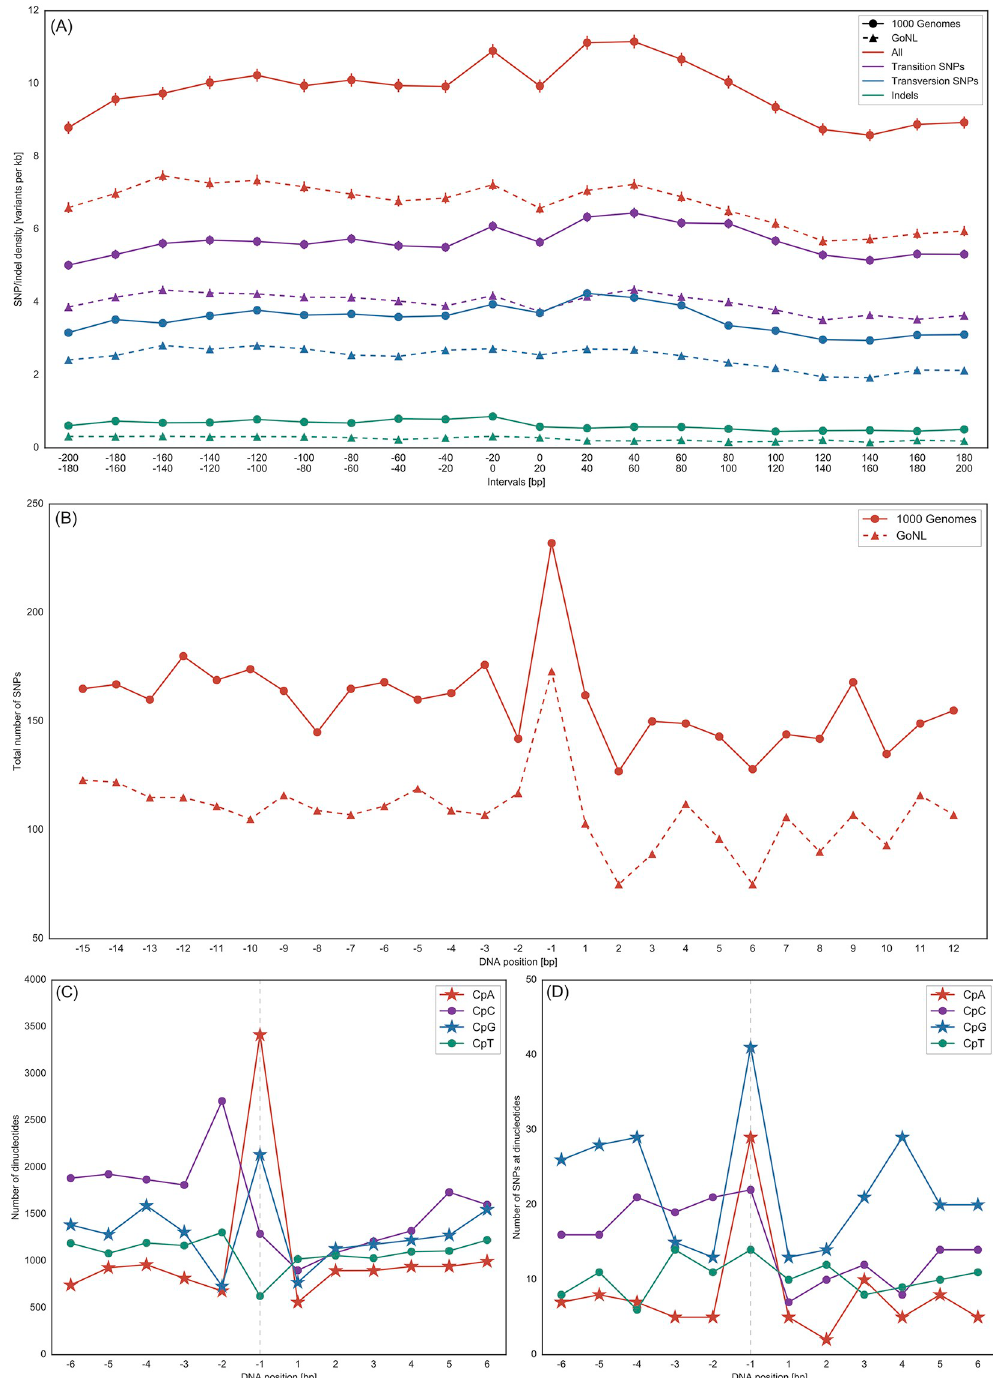
Fig 4. SNP and dinucleotide distribution around the TSS. A: Average SNP and indel density (1000G and GoNL data) around the TSS ( ± 200 bp) of all RefSeq genes. The standard error of the mean is visualized for every datapoint. B: SNP pattern in direct vicinity ( − 15 to +12) of the TSS considering 1000G and GoNL data. Position 1 denotes the first intragenic nucleotide. C: Distribution of dinucleotides starting with cytosine in the flanking region of the TSS of all RefSeq genes. CpG and CpA dinucleotides are prevalent. D: Number of SNPs (1000G data) at individual dinucleotides. The majority of SNPs resides at CpG dinucleotides.